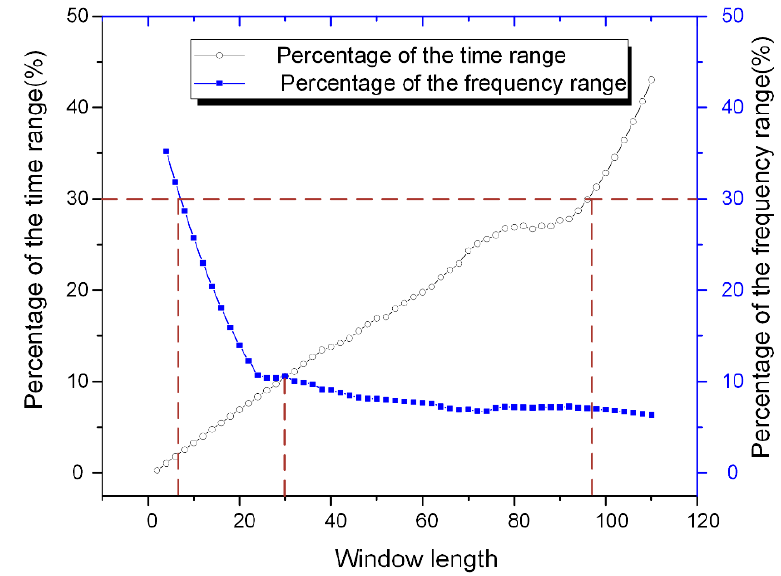
Figure 12. Percentages of the time and frequency decline ranges along the window lengths.